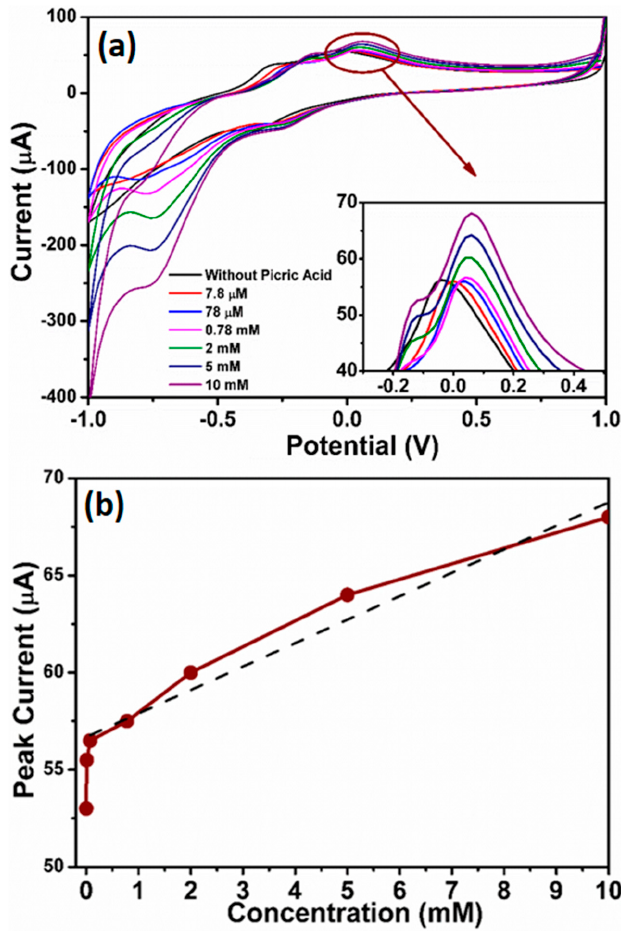
Figure 5. ( a ) Average cyclic voltammogram (CV) curves of the fabricated SPE at various concentrations of picric acid; and ( b ) Variation in the anodic peak current with concentration of picric acid.